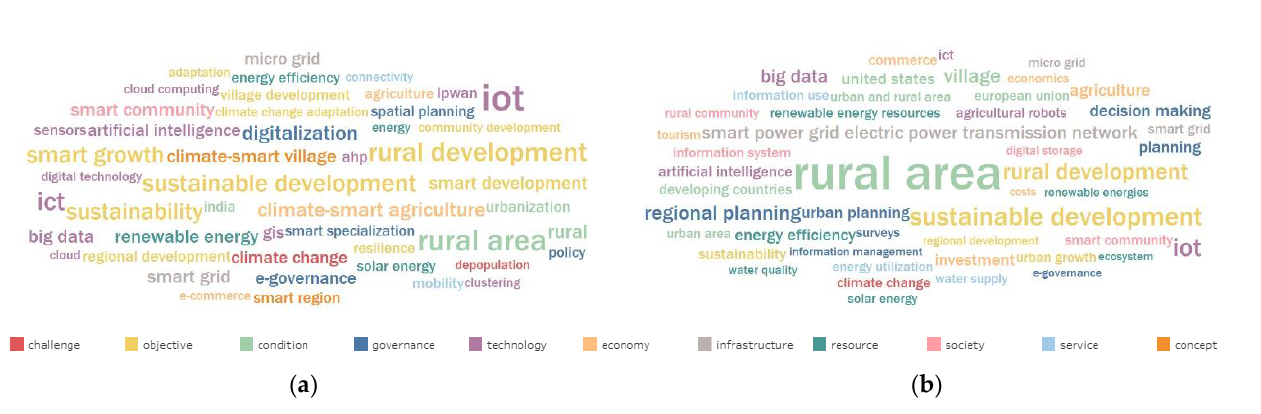
( c ) Figure 4. Collaboration networks between authors, institutions, and countries. ( a ) Authors; ( b ) In- stitutions; ( c ) Countries. 3.2.3. Hotspots, Structures, and Trends According to the Scopus subject area count, among the 425 retrieved documents, the top five most common subject areas were computer science (n = 190), social sciences (n = 150), engineering (n = 141), energy (n = 96), and environmental science (n = 96) along with 18 other subject areas. This indicates that rural smart development involves multidiscipli- nary knowledge. In this section, we are interested in hotspots, conceptual and intellectual structures, and the evolution of trends in the smart village